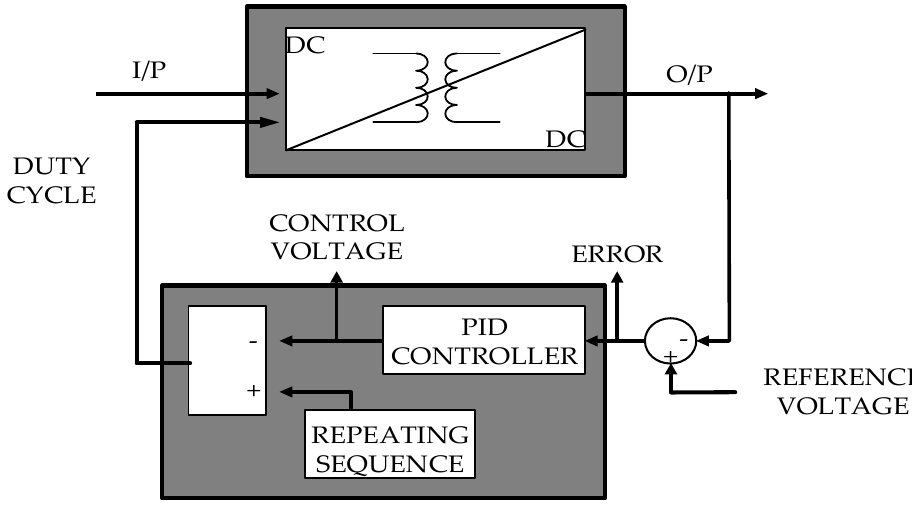
Figure 8. Block diagram of PID control.